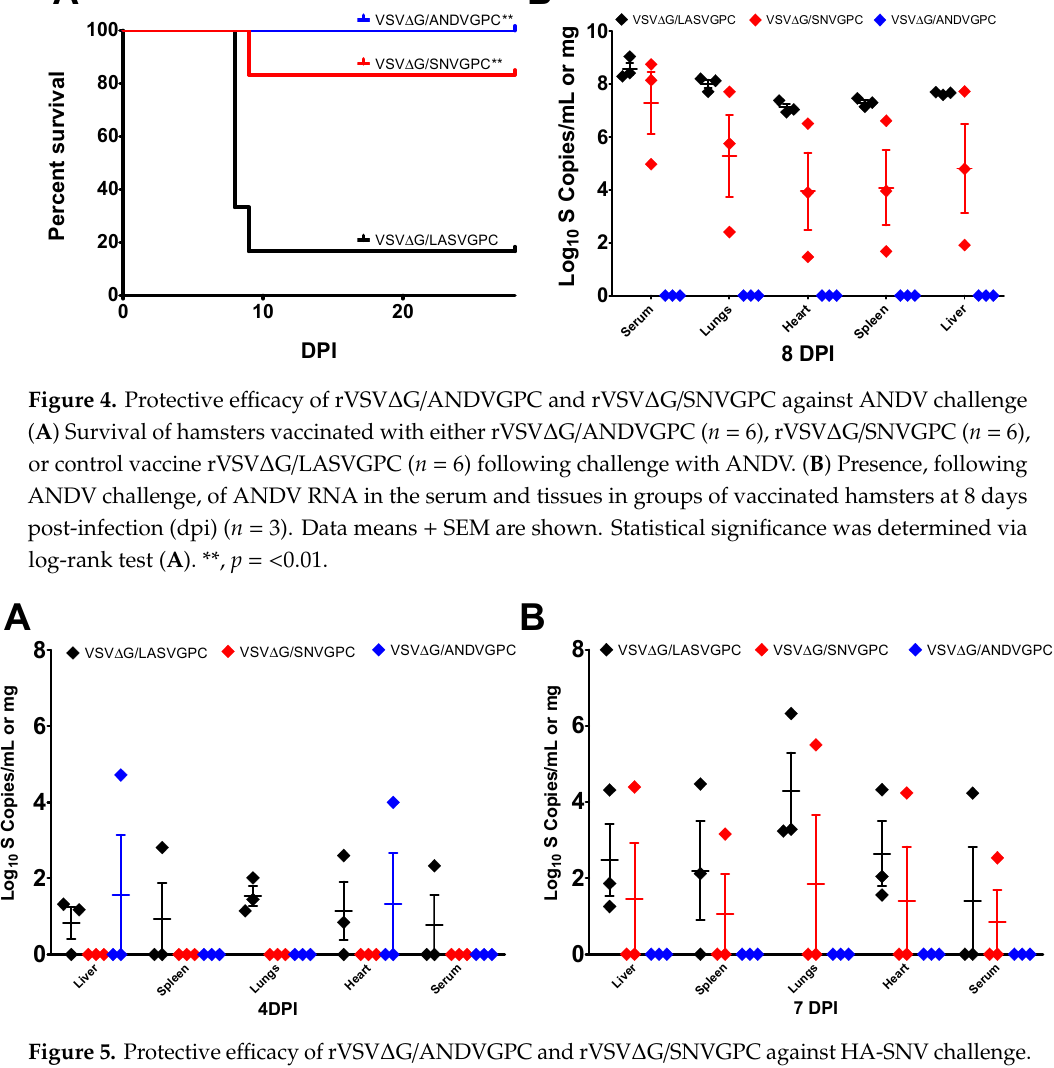
Figure 5. Protective efficacy of rVSV Δ G/ANDVGPC and rVSV Δ G/SNVGPC against HA-SNV challenge. Presence of SNV RNA in the serum and tissues of vaccinated hamsters at ( A ) 4 dpi and ( B ) 7 dpi ( n = 3/group) following HA-SNV challenge. Data means + SEM are shown.